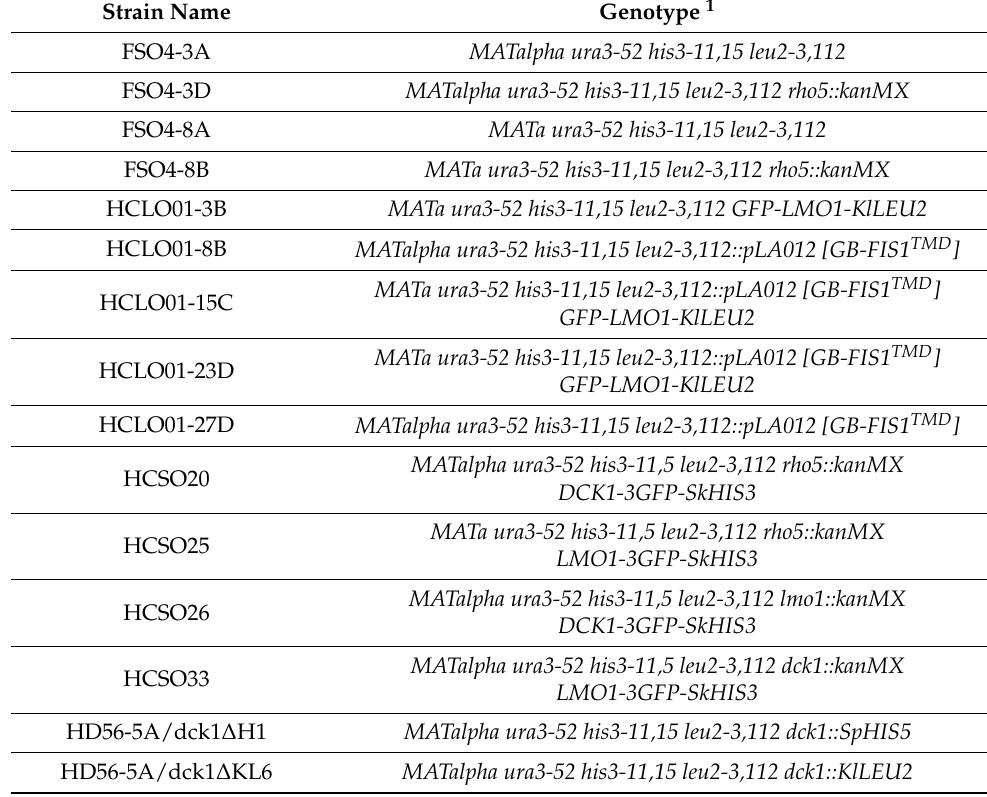
Table 1. Strains constructed in this